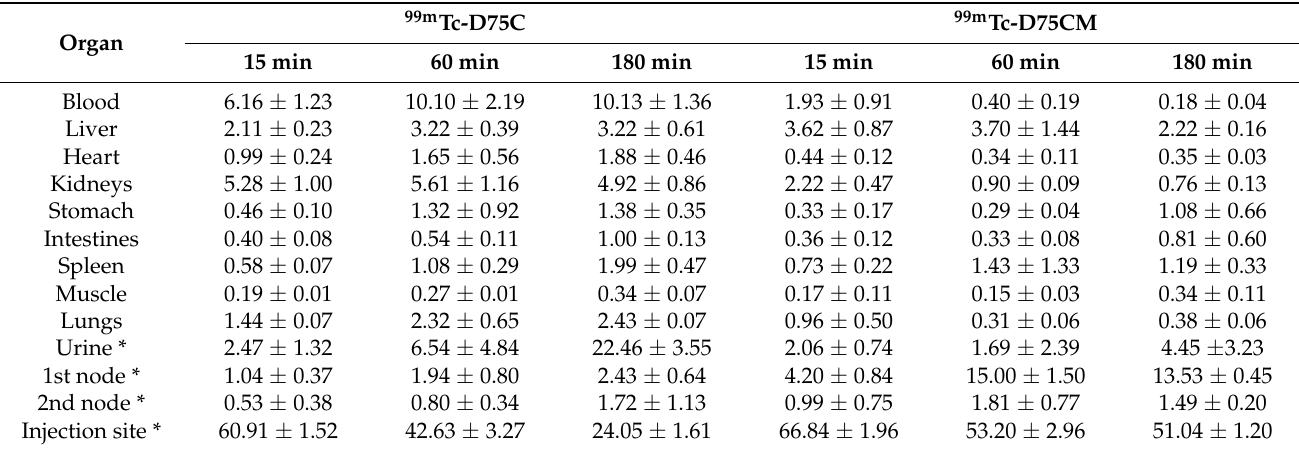
Table 2. Biodistribution of radioactivity after subcutaneous injection to the rear footpad of 99m Tc-D75C and 99m Tc-D75CM in mice at (a) 15, (b) 60, and (c) 180